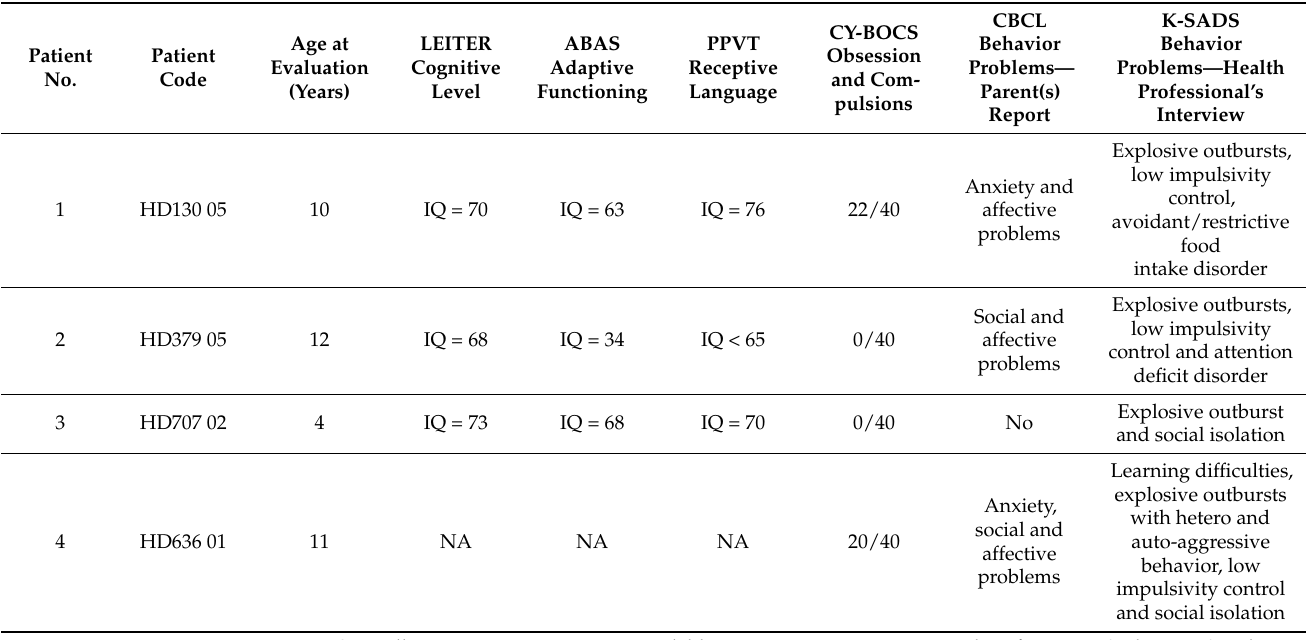
Table 3. Cognitive and behavioral